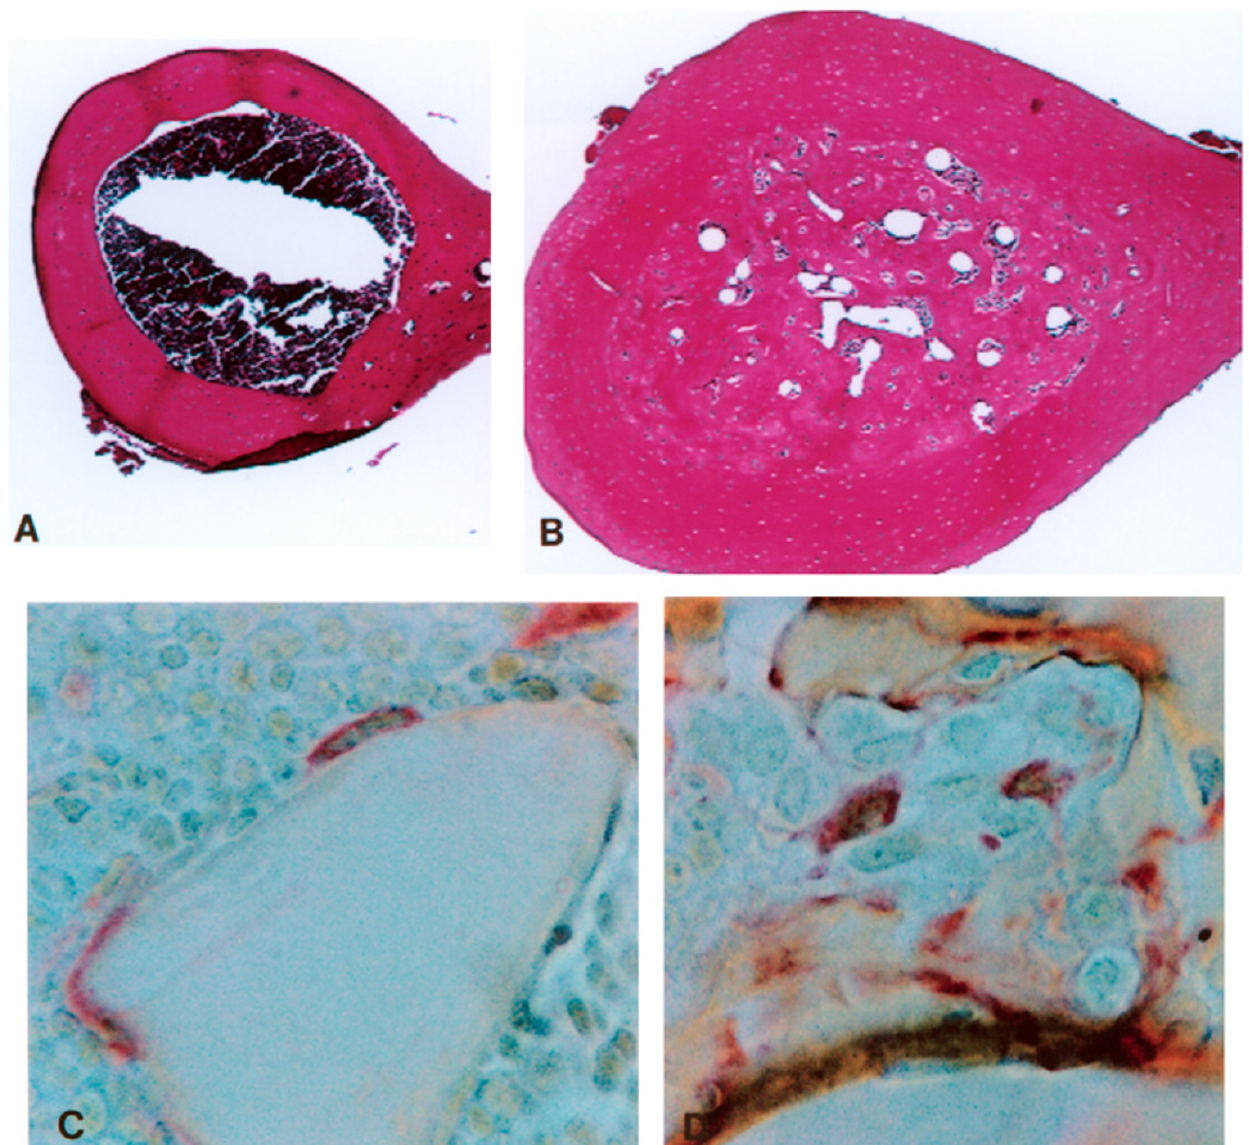
Figure 2 Photomicrographs of decalcified (A and B) and methacrylate-embedded (C and D) femoral specimens. Cross- sections of normal mice show a normal marrow cavity (Fig. 2A) which is in sharp contrast to the appearance of the cross-sec- tion from an estradiol-treated mouse (Fig. 2B) in which only small islands of marrow are present. Localization of Ocl using tar- trate-resistant acid phosphatase (TRAP) localization in metaphyseal bone from a normal mouse (Fig. 2C) and from an estradiol- treated mouse (Fig. 2D). (Fig. 2A and 2B, H&E, X 43; Fig. 2C and 2D, TRAP, X